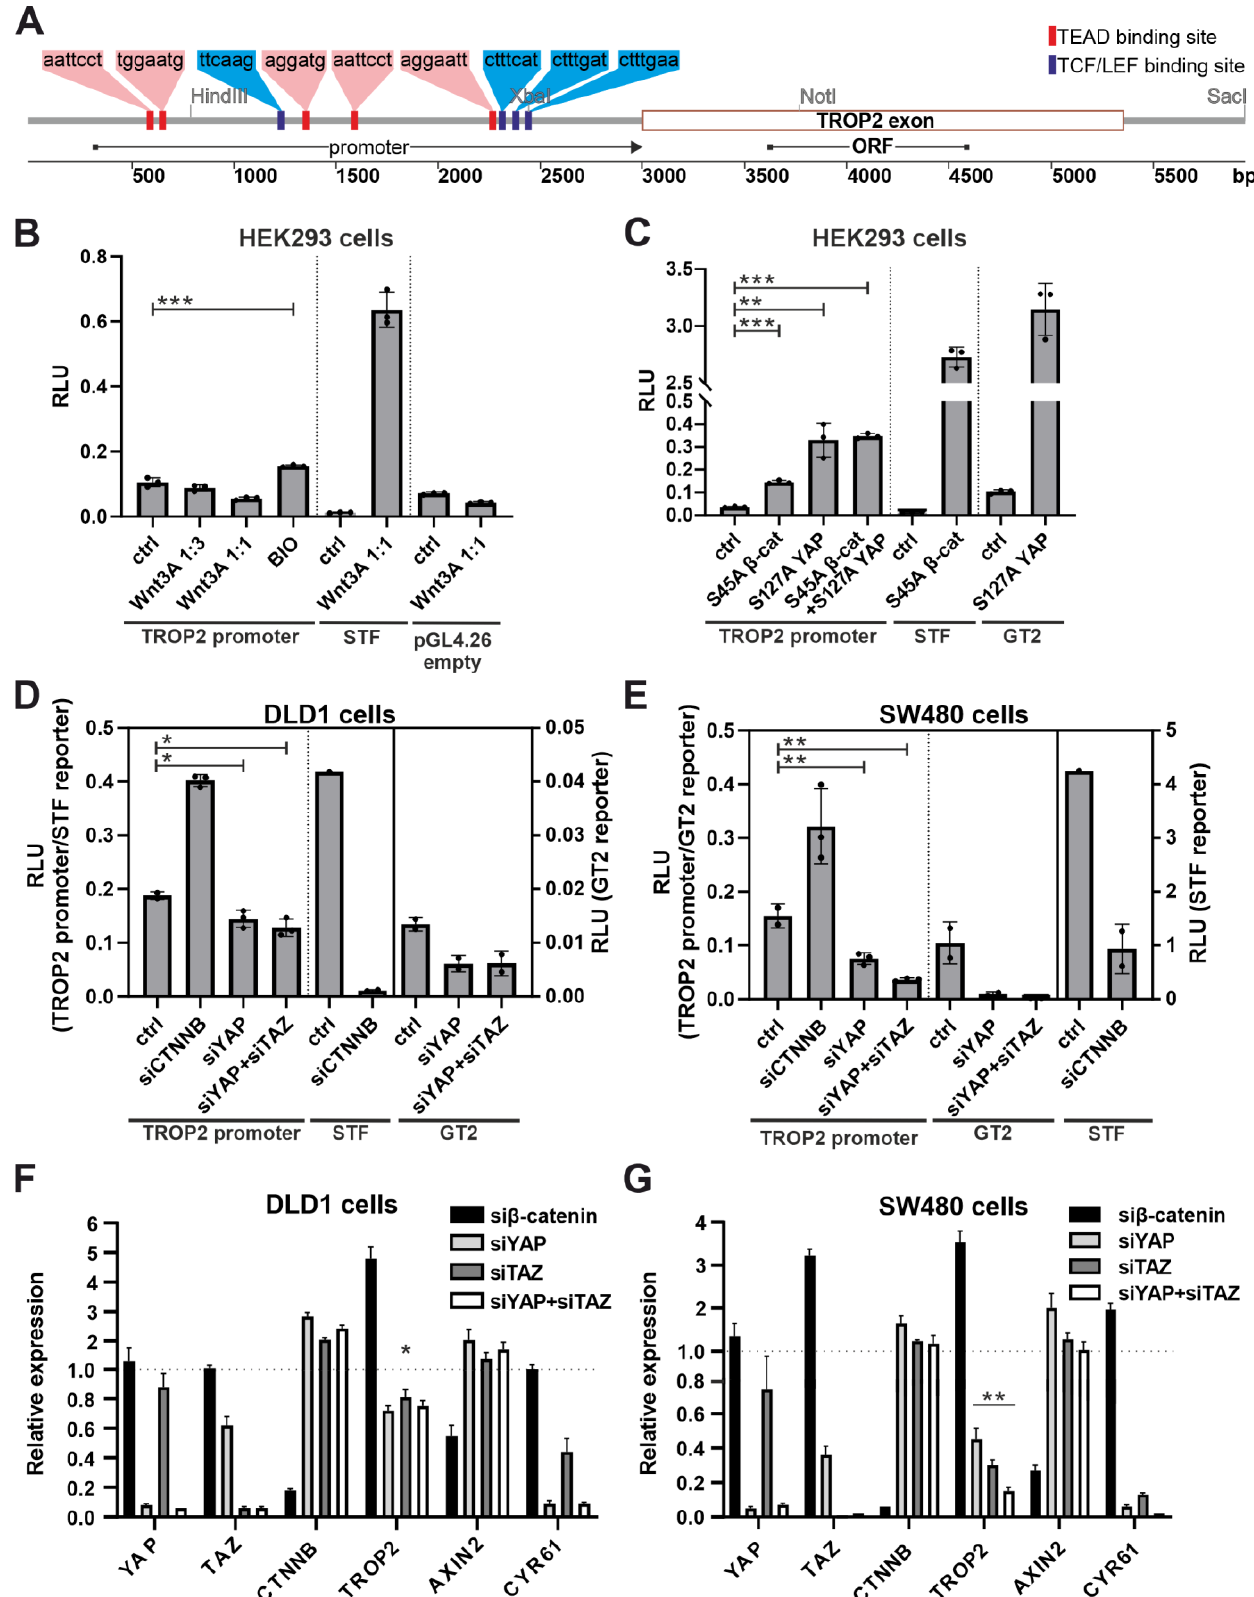
Figure 7. The human TROP2 promoter harbors multiple binding sites for transcription factors TEAD and TCF/LEF and is activated by YAP. ( A ) A graphical schema of the human TROP2 locus showing the regulatory/promoter region harboring the TEAD and TCF/LEF binding sites (red and blue bars